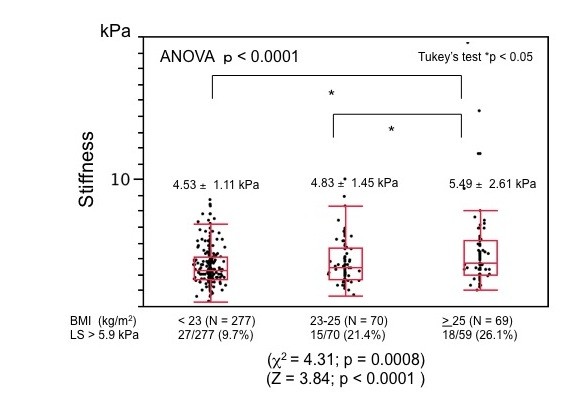
Comparison of liver stiffness among three groups based on BMI. Mean LS significantly differed among groups and were corrected for multiple comparisons according to Tukey's test. Proportions of individuals with LS above normal upper limit significantly differed (χ2 test and Cochran-Armitage test for trends).